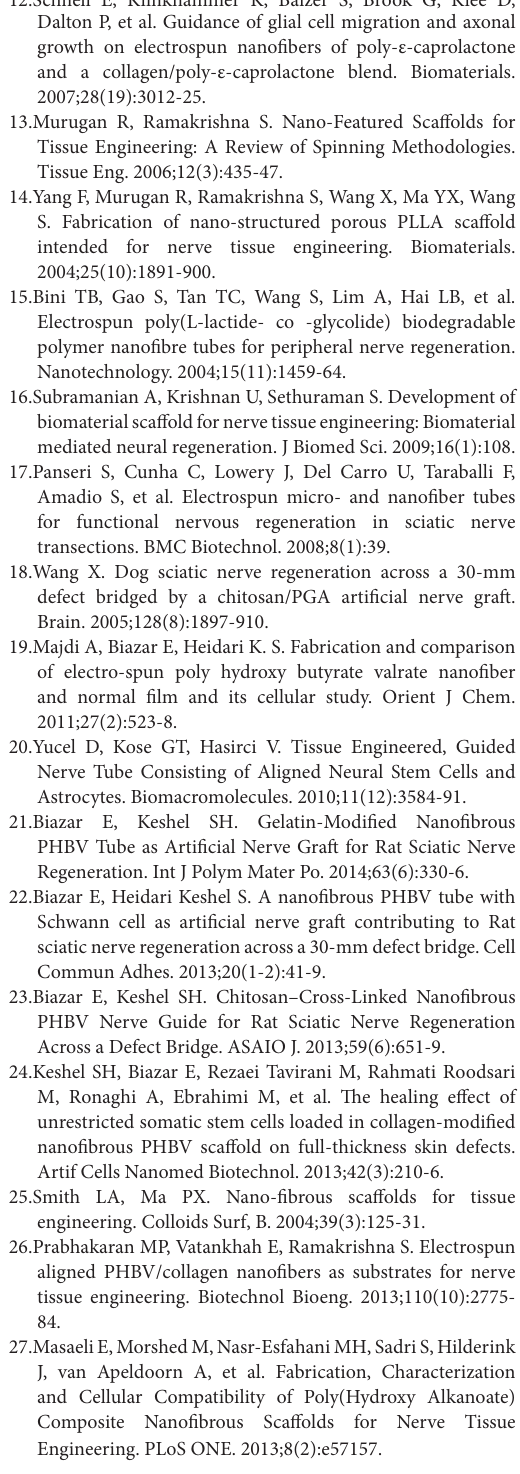
111 Nanomed Res J 1(2): 107-111, Autumn